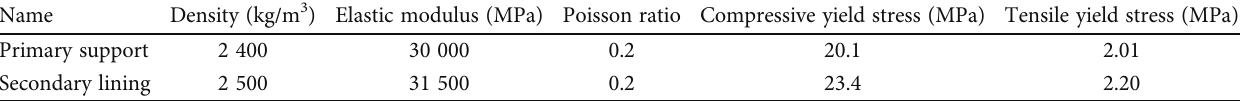
Table 2: Mechanical parameters of